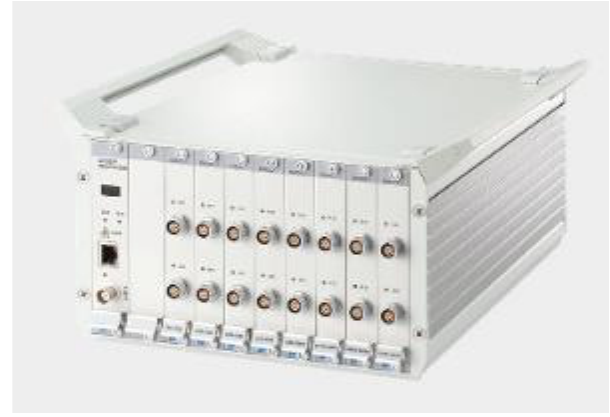
Figure 10. DHHP-20 ultra-dynamic strain gauge.